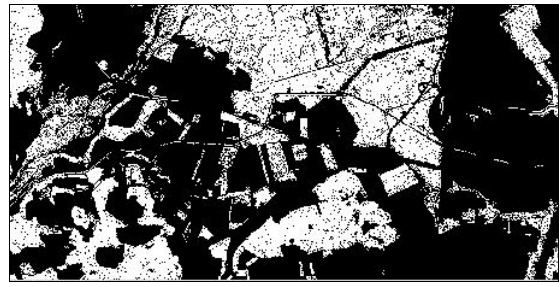
Figure 6. Example of black and white image conversion.